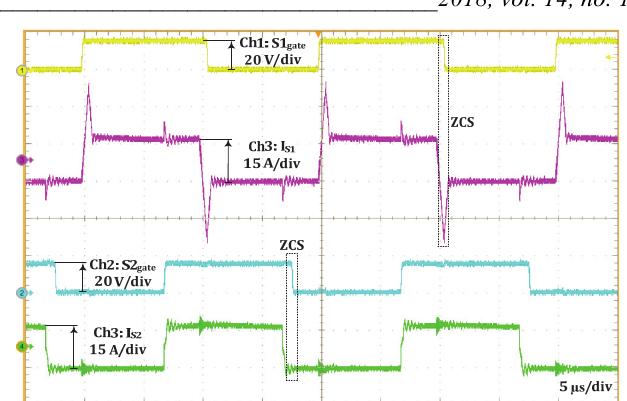
Fig. 5. Experimental waveforms of an APRC converter: Ch1 – V Trp , Ch2 – I in , Ch3 – I Trp and Ch4 – V Trs .